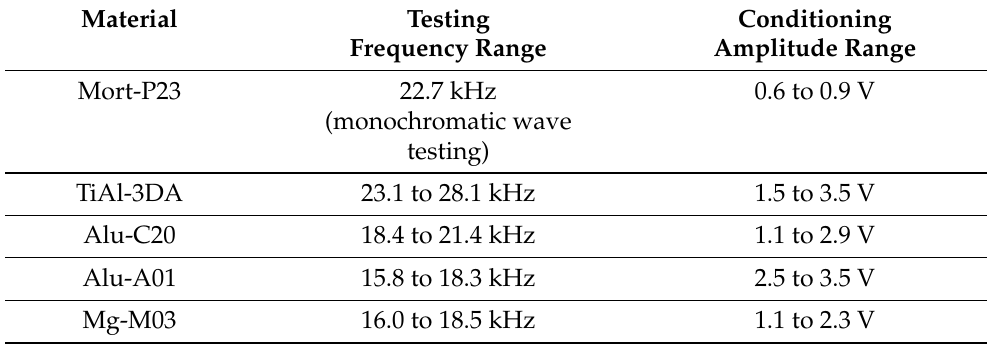
Table A1. Frequency and input amplitude ranges used for testing the different